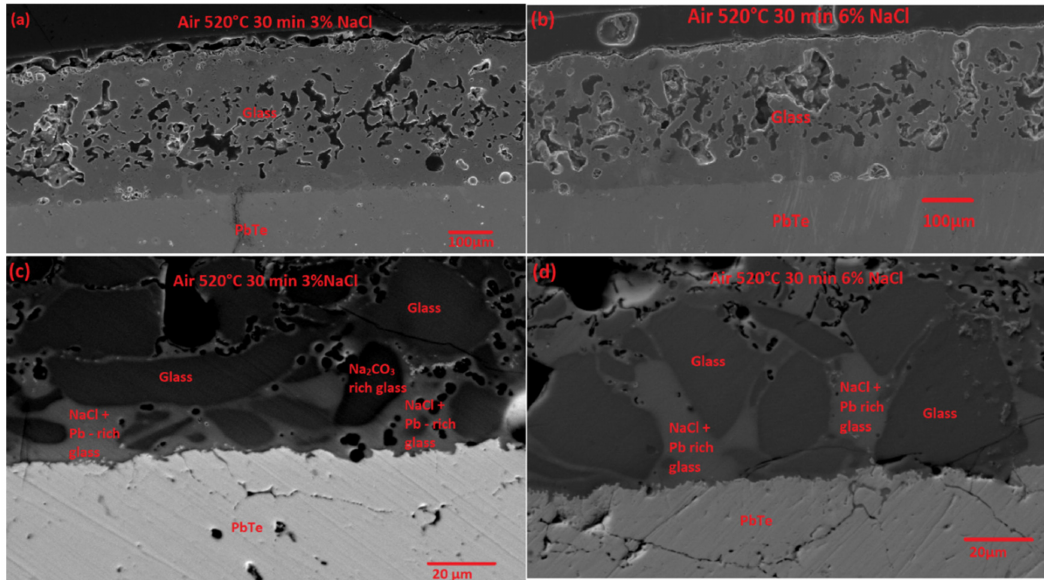
Figure 5. Scanning electron microscopy (SEM) micrographs of glass coated PbTe, following 3 wt. % ( a , c ) and 6 wt. % ( b , d ) NaCl addition. ( a , b ) are secondary electrons images while ( c , d ) are back scattered electrons